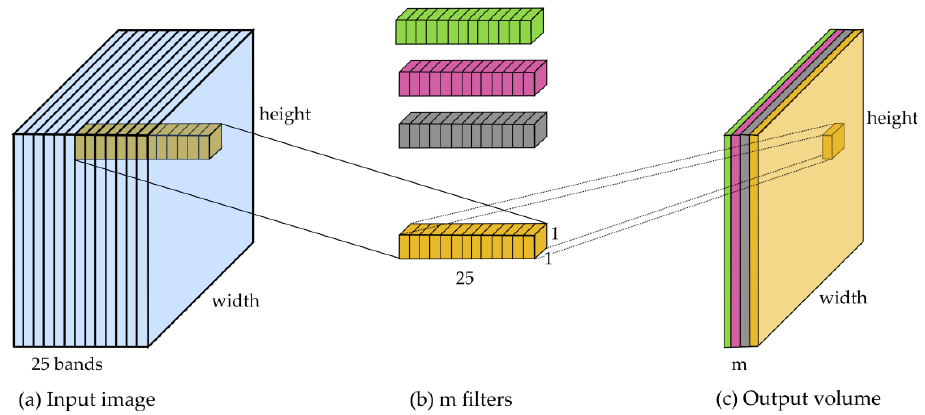
Figure 3. Band learning module structure. The multispectral image ( a ) is convolved with m filters with size 1 × 1 × 25 ( b ) that generate an output volume ( c ) with m bands.